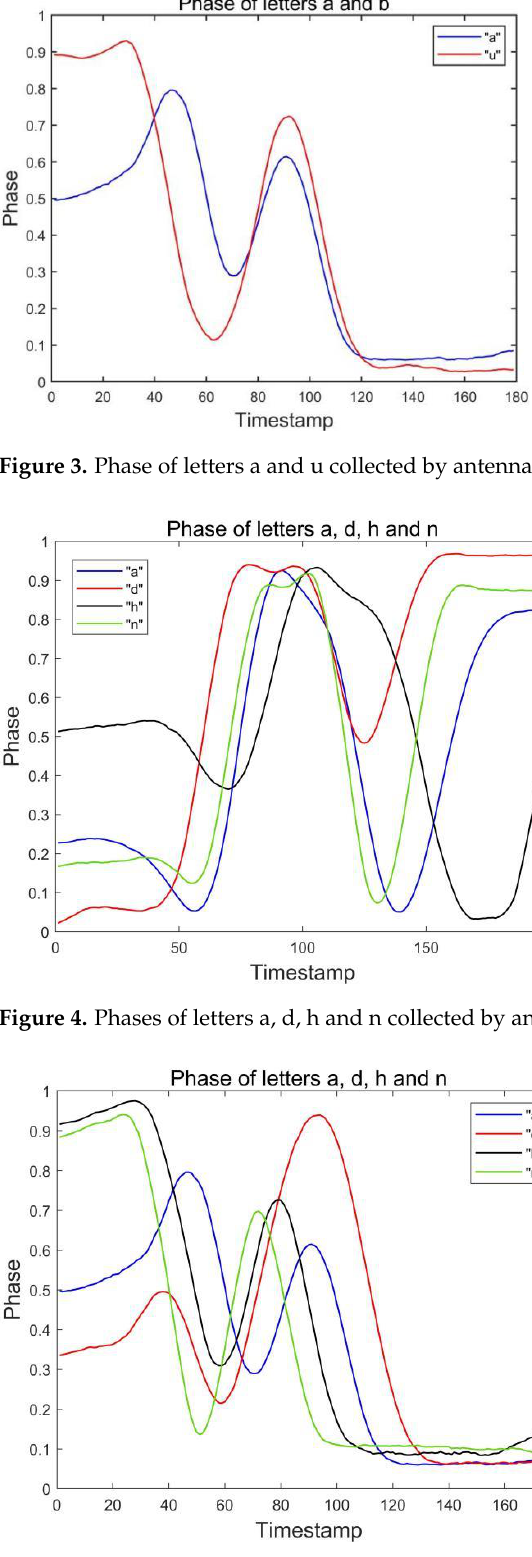
Figure 3. Phase of letters a and u collected by antenna #2.